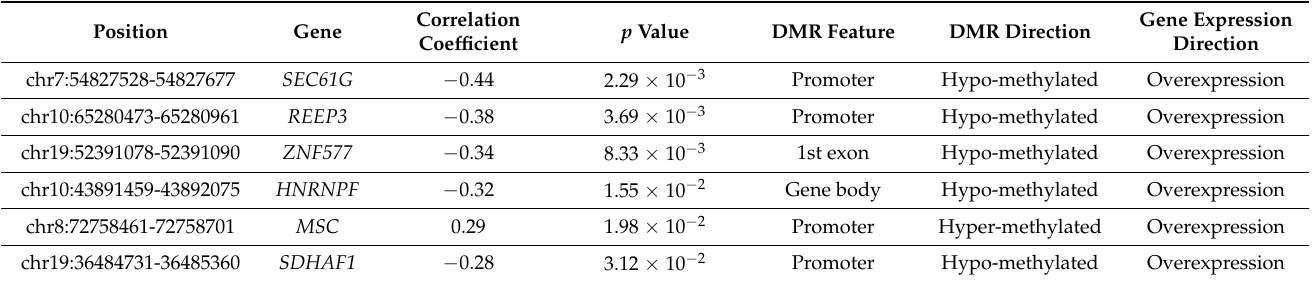
Table 1. DMR–gene expression